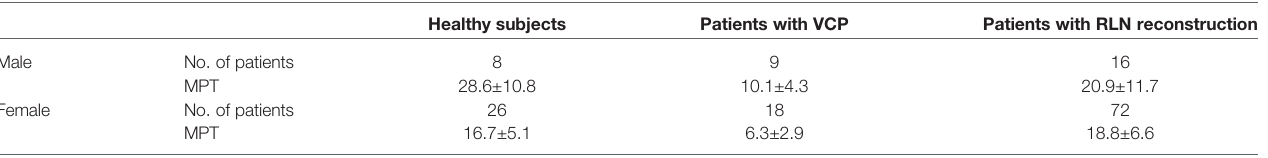
TABLE 2 | Maximum phonation time in healthy subjects, patients with vocal cord paralysis, and patients who underwent reconstruction of the recurrent laryngeal nerve (9).